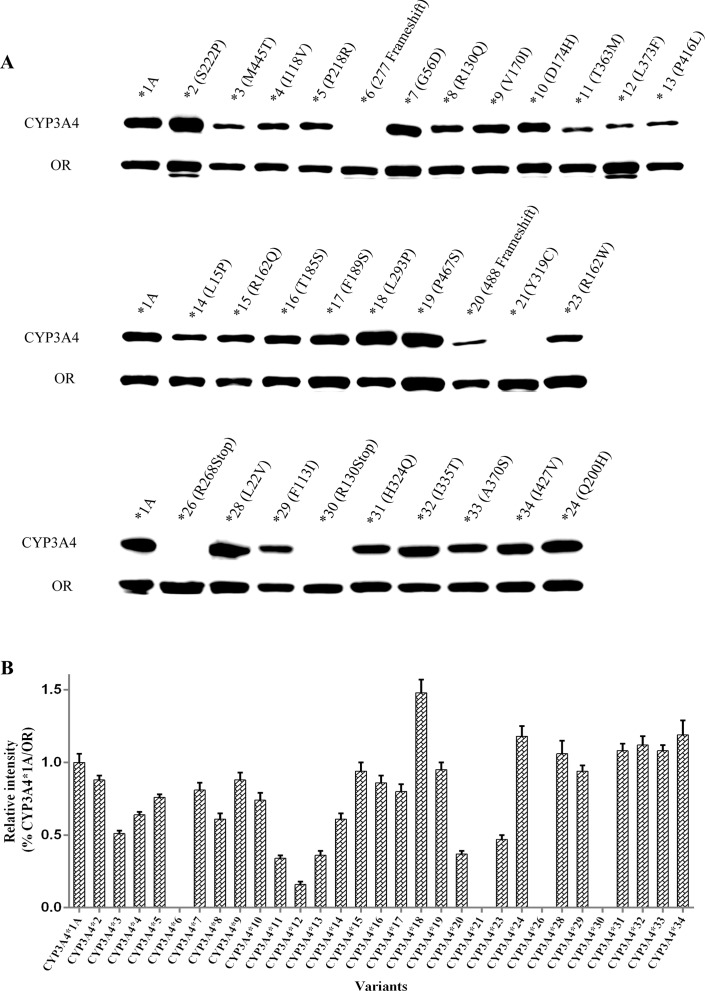
Expression of 31 CYP3A4 alleles in Sf21 cells. The expressed OR and CYP3A4 proteins were detected by western blotting with antibodies against OR and CYP3A4, respectively (A). Relative intensities (% of CYP3A4*1A/OR) (B). Each bar represents the mean ± SD from three experiments.